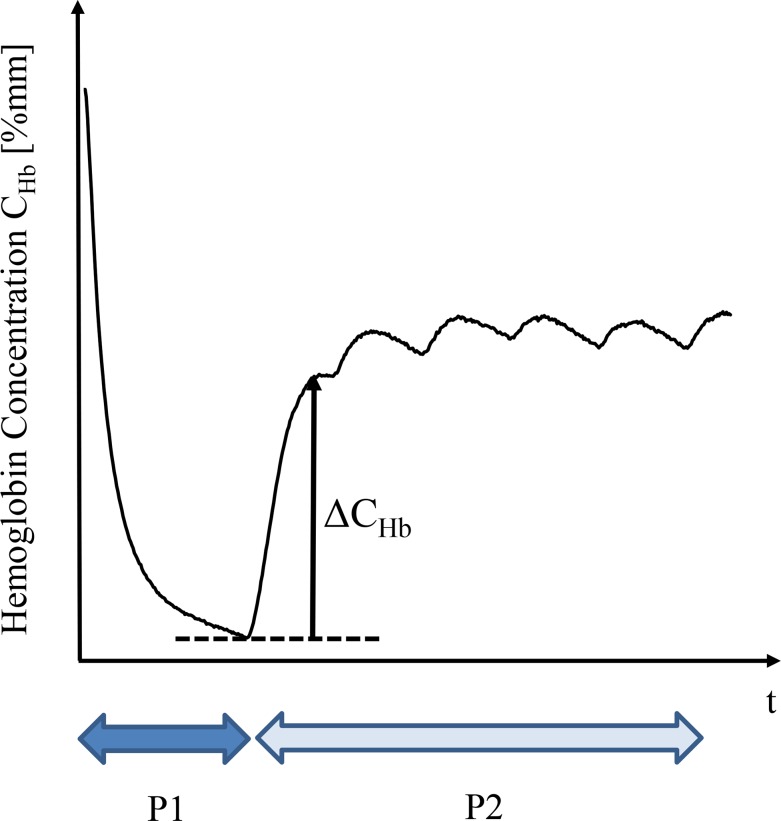
An index of blood reflow characteristic ΔCHb.